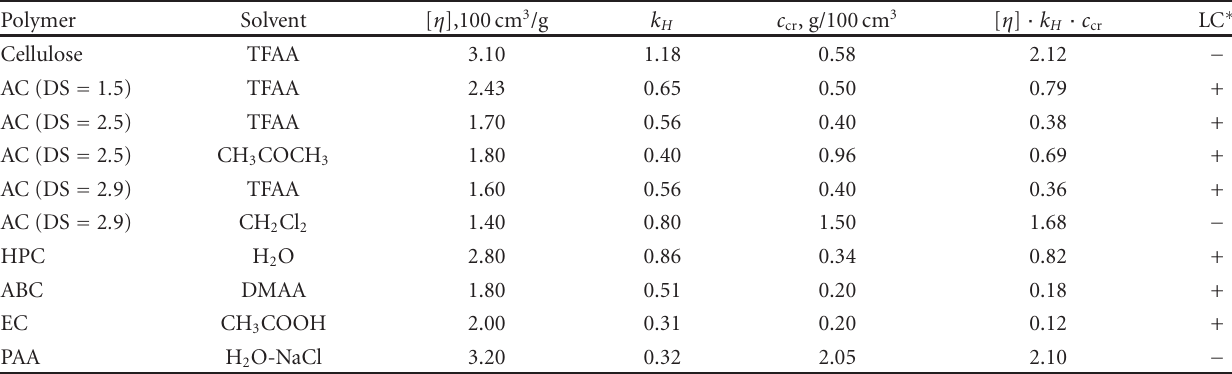
Table 8: Hydrodynamic characteristics of cellulose and its derivatives solutions as well as polyacrylic acid.